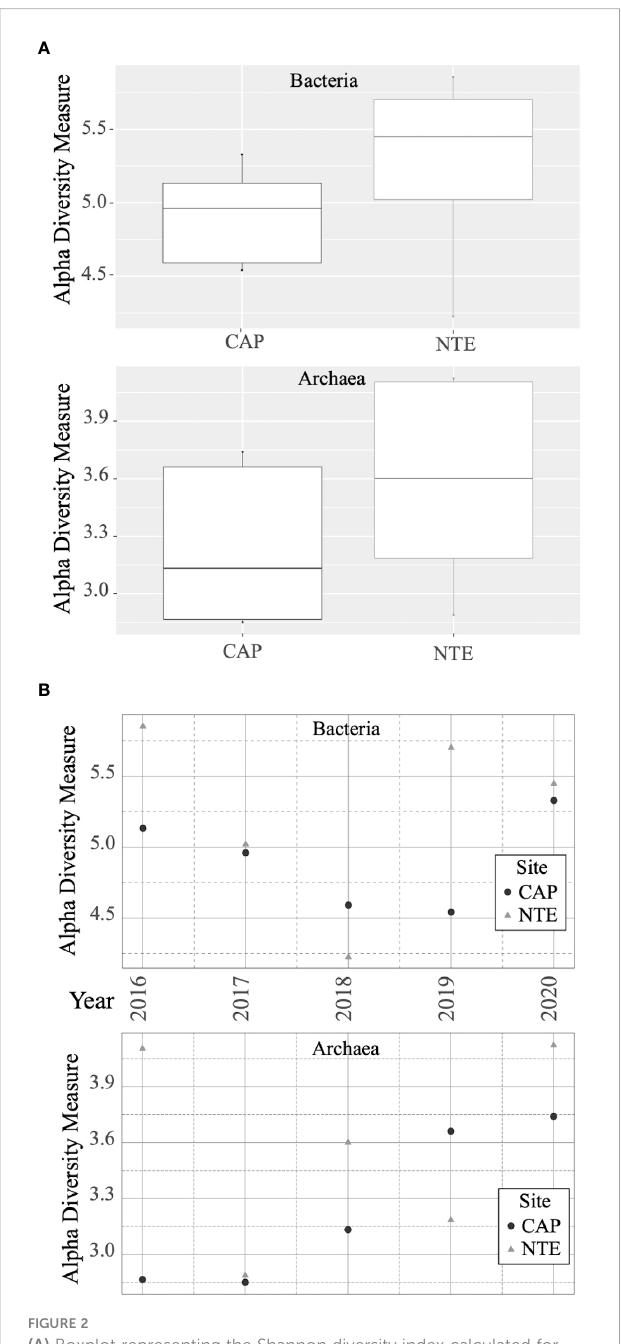
FIGURE 2 (A) Boxplot representing the Shannon diversity index calculated for each site (Capelinhos in black and North Tour Eiffel in gray) for bacterial and archaeal communities. (B) Shannon diversity index calculated for each site (Capelinhos in black and North Tour Eiffel in gray) and each year for bacterial and archaeal